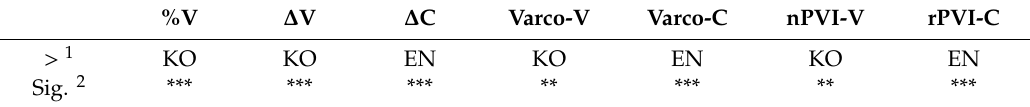
Table 3. Significance results with Linear Mixed E ff ects (LME) for English and